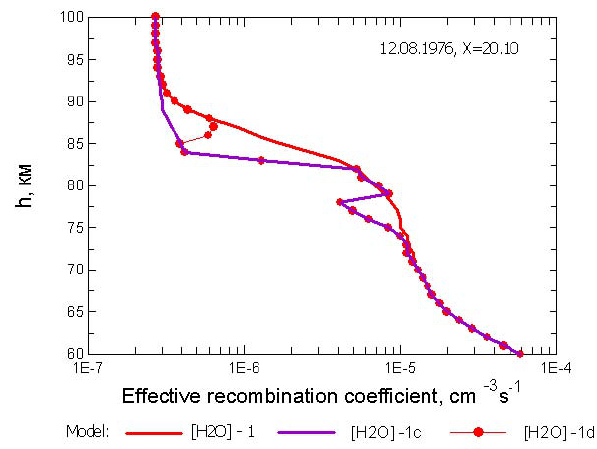
Fig. 12. Effective recombination coefficient calculated for 12 Au- gust 1976 at 10:54LT, with a solar zenith angle of 28.10 ◦ and the H 2 O-1 (red line without symbols), H 2 O-1c (violet line) and H 2 O- 1d (red line with symbols)